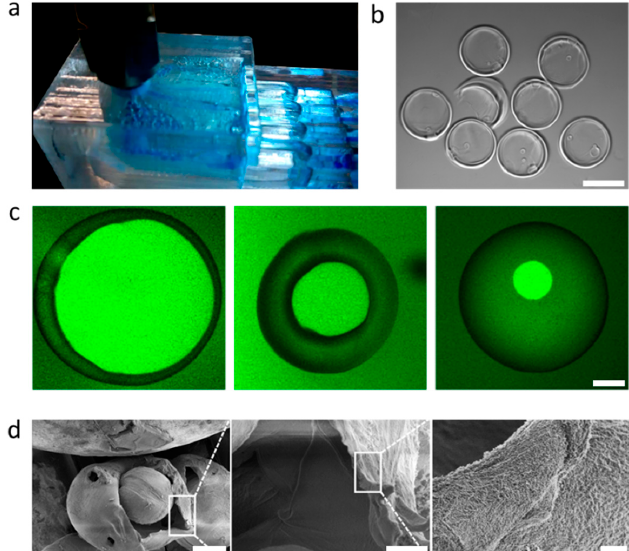
Figure4. ( a )Photographoftheoutletandcollectionchannelofafour-foldparallelizeddevice. ( b )hollow sPEG based microgels of ~ 500 µ m in diameter after drying. ( c ) Confocal scanning laser microscope image of hollow microgels labeled with FITC- functionalized dextran. The fluorescent dextran was allowed to di ff use into the polymer network to highlight the inner cavities of di ff erent diameters. The microgels were produced at applied pressures of ( left ) p i = 23 mbar, p m = 19 mbar, ( middle ) p i = 24 mbar, p m = 27 mbar, (right) at p i = 23 mbar, p m = 28 mbar. p o was set to 200 mbar. ( d ) Cryo-SEM images shows capsules. Scale bars represents ( b ) 500 µ m, ( c ) 100 µ m, ( d ) 150 µ m, 25 µ m, and 5 µ m ( left to right